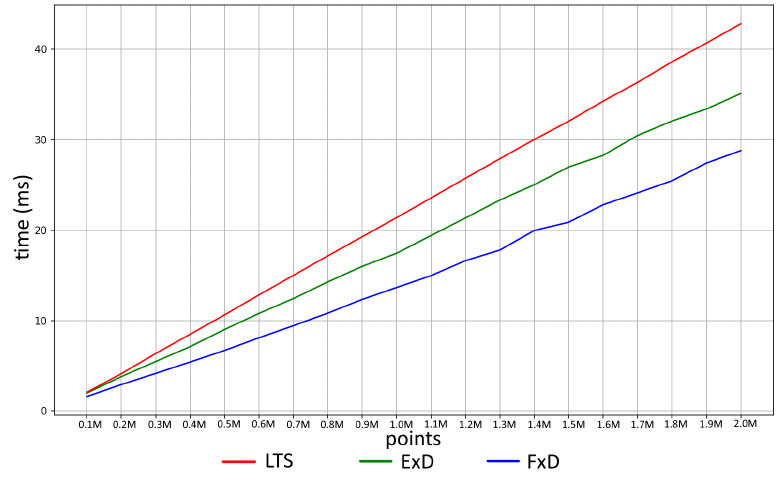
Figure 13. Average processing times for linearized taut string (LTS) (red), exact dividing a tube (ExD) (green) and fixed position dividing a tube (FxD) (blue) algorithms in milliseconds. On the horizontal axis, the corresponding sizes of discrete functions are